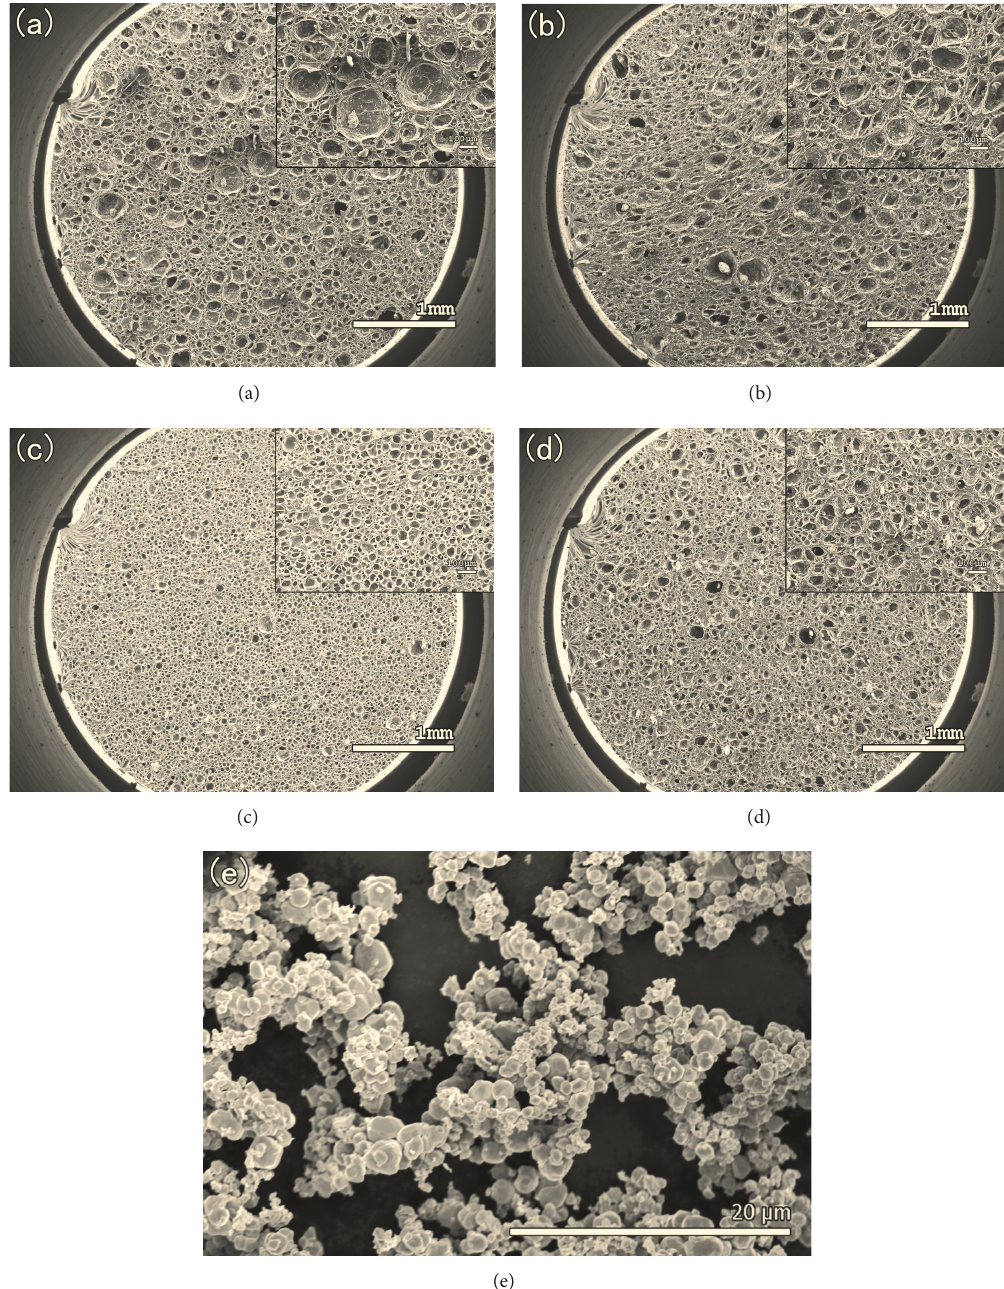
Figure 4: SEM images of fractured surface of SFM/NBR-PVC materials and SFM: (a) 0 wt%, (b) 10 wt%, (c) 30 wt%, (d) 40 wt%, (e) SFM.